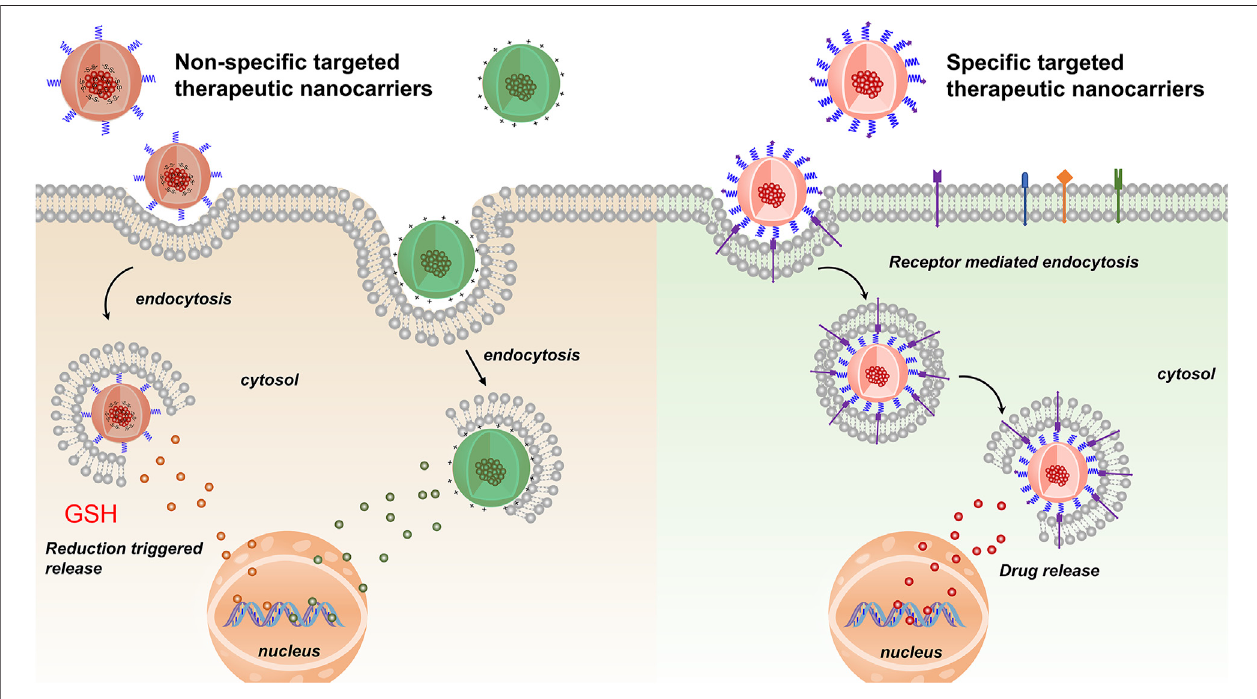
FIGURE 1 | Non-speci fi c and speci fi c targeted therapeutic nanocarriers for treatment of BC.